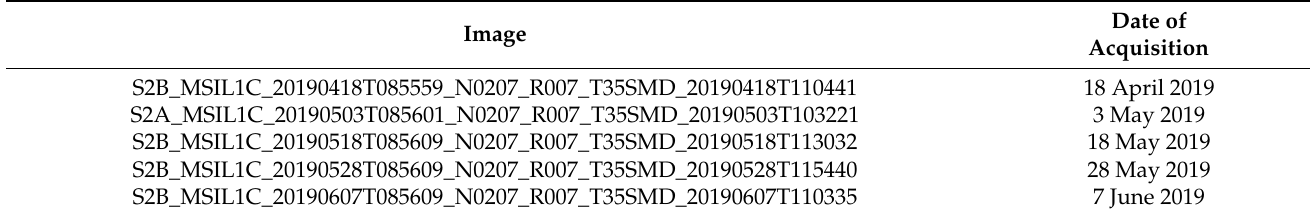
Figure 2. An example of the available training data of marine pollution for the study area of Mytilene Island, Greece (pixel sizes of A1 to A6 are 10 m by 10 m) [40]. Table 1. Description of the Sentinel-2 level-1 C images that can be used for debris mapping.